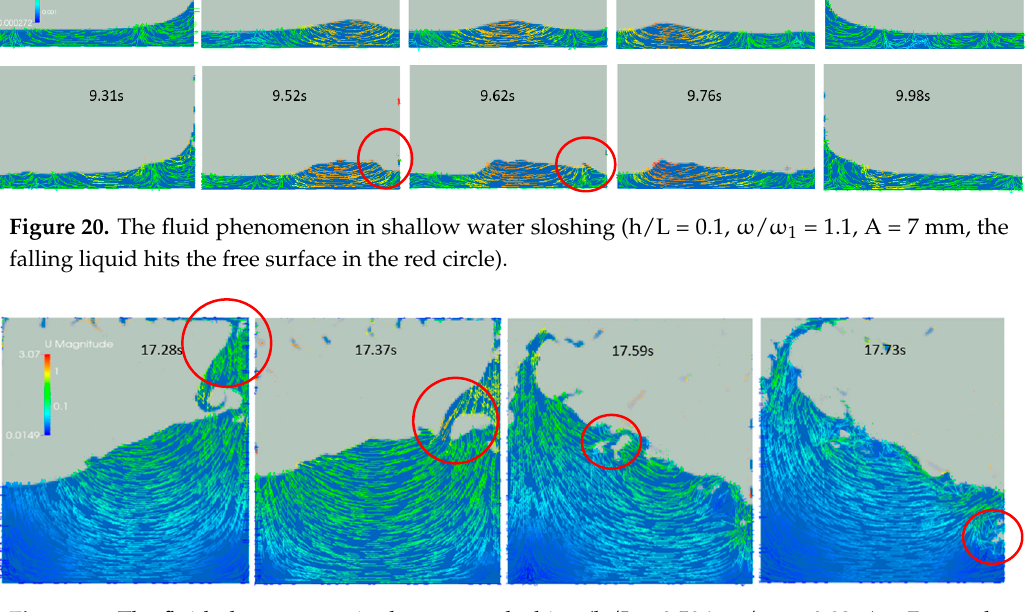
Figure 21. The fluid phenomenon in deepwater sloshing (h/L = 0.596, ω / ω 1 = 0.92, A = 7 mm, the phenomena of roof slamming and aerification occurred in the red circle).